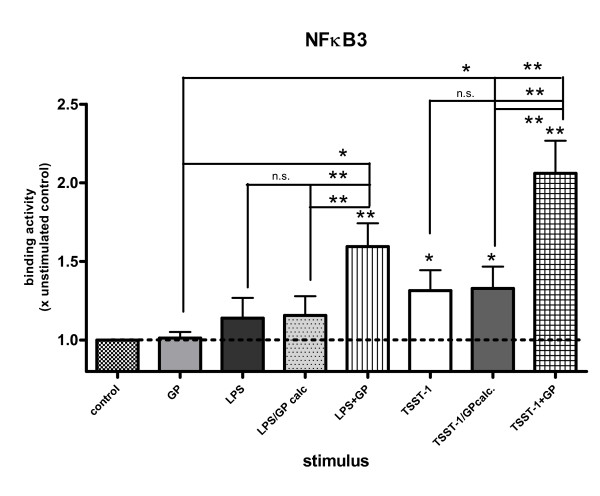
GP modulated LPS- and TSST-1-induced binding to a new NFκB3 site in the IL-1RA promoter. Binding was enhanced for GP + LPS and GP + TSST-1, when compared to LPS, TSST-1, GP, GP/LPS calc. or GP/TSST-1 calc., respectively (* = p < 0.05; ** = p < 0.01). Medium control levels were set equal to 1 ± SEM (n = 6). DNA binding was assessed by EMSA (see methods).